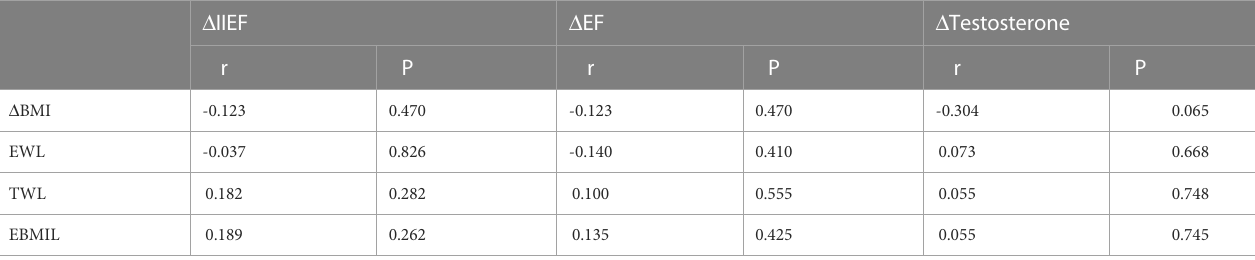
TABLE 7 Univariate analysis of the change in IIEF scores, EF scores, and testosterone level. D